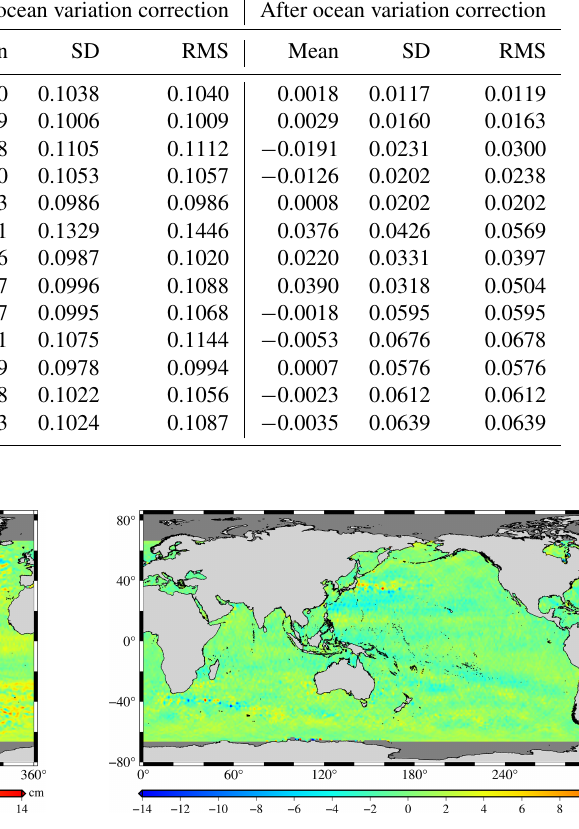
Figure 3. Sea surface height differences between Jason-1/GM and the SDUST2020 model before oceanic variability correction.